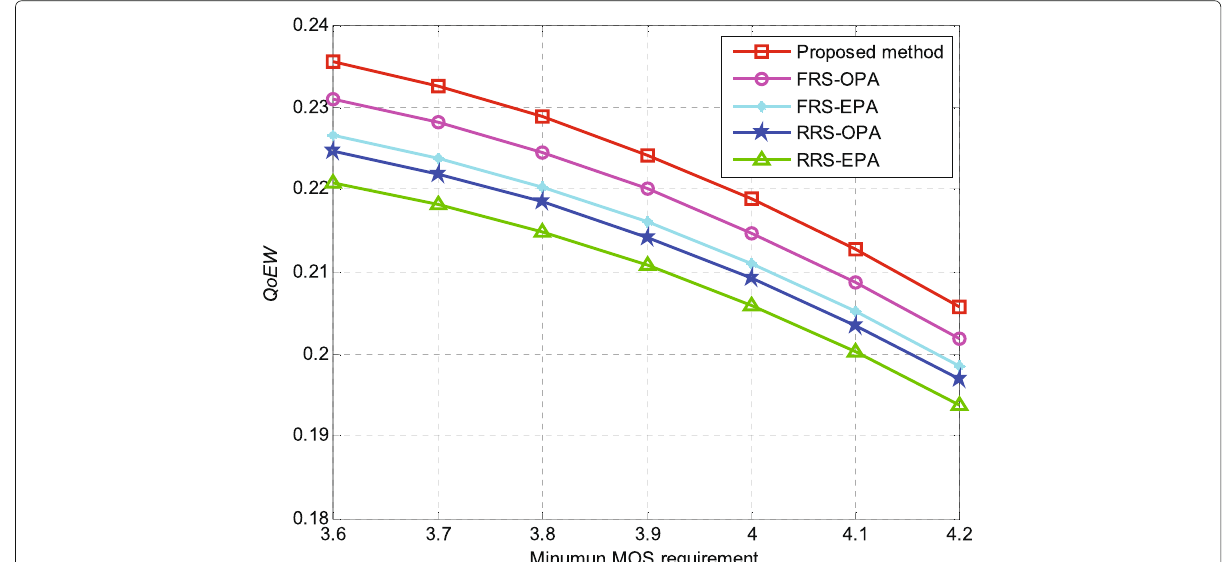
Fig. 6 QoEW versus minimum MOS